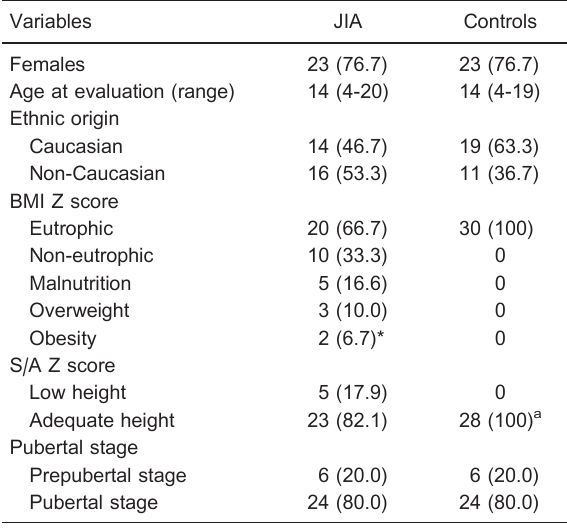
Table 1. Demographic characteristics, nutritional status, and pubertal stage of patients with juvenile idiopathic